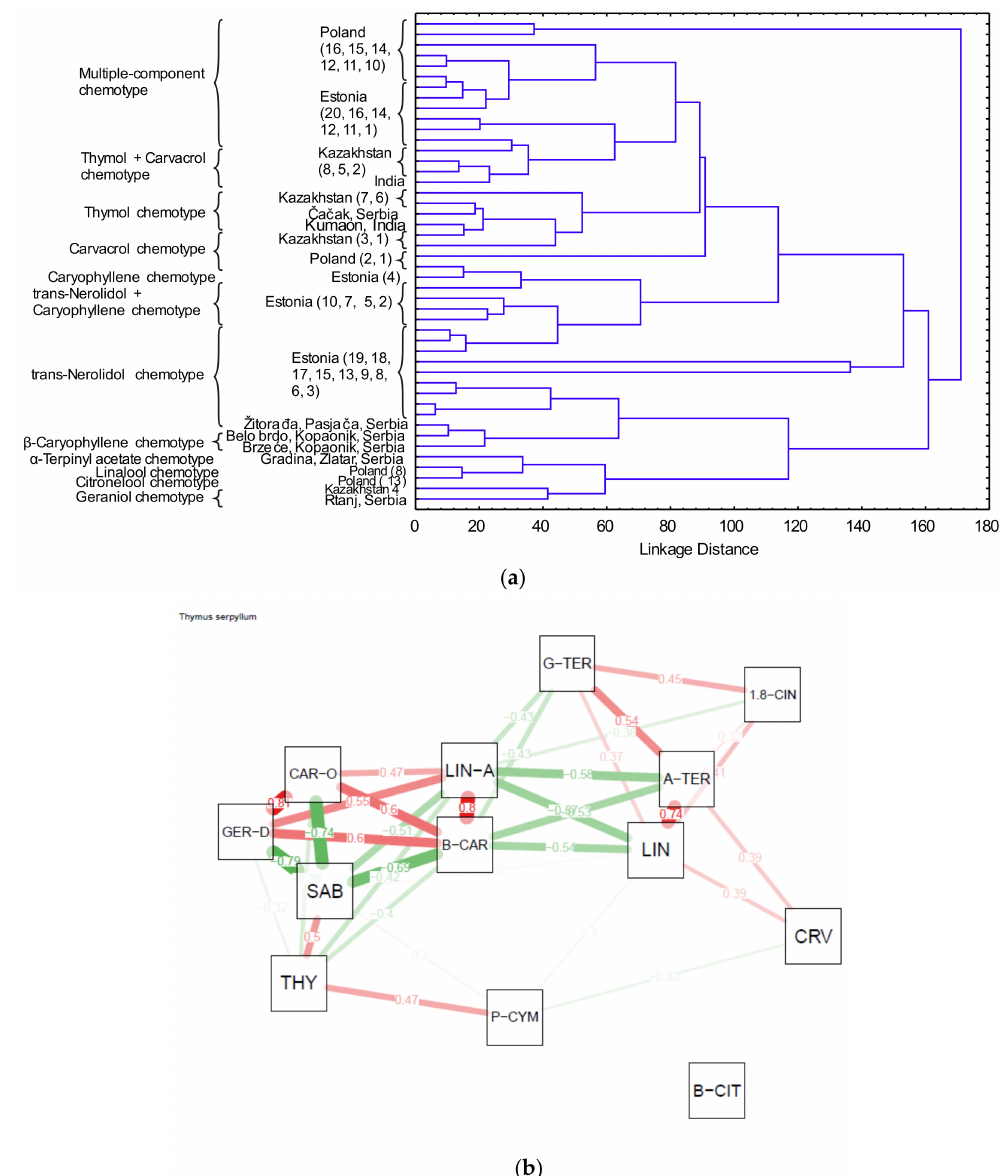
Figure 2. ( a ) Dendogram of the EO constituents of T. serpyllum from this study and from literature reports (the samples are marked according to Table 4); ( b ) correlation network based on T.